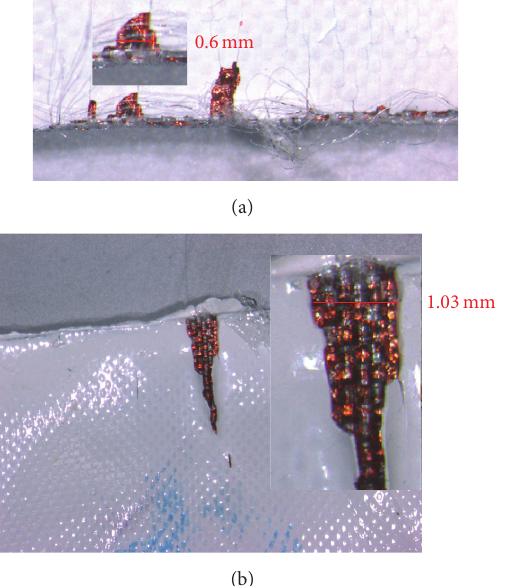
Figure 11: Cracks in the protective coating; magnification of the tags is ×